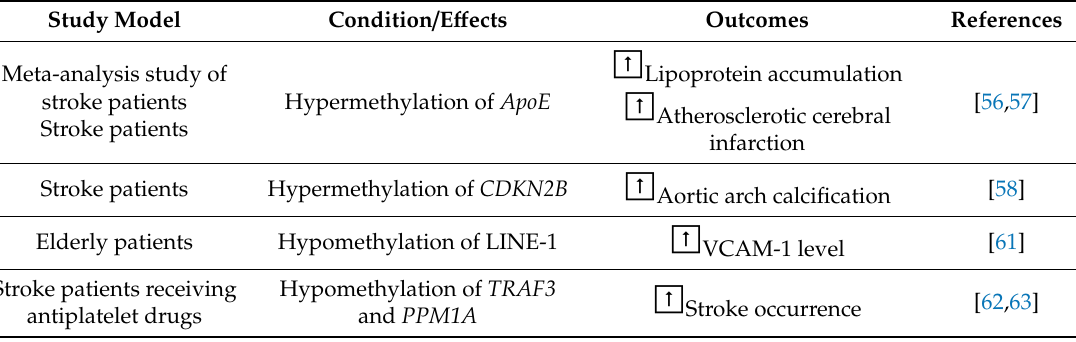
Table 1. DNA methylation in IS.